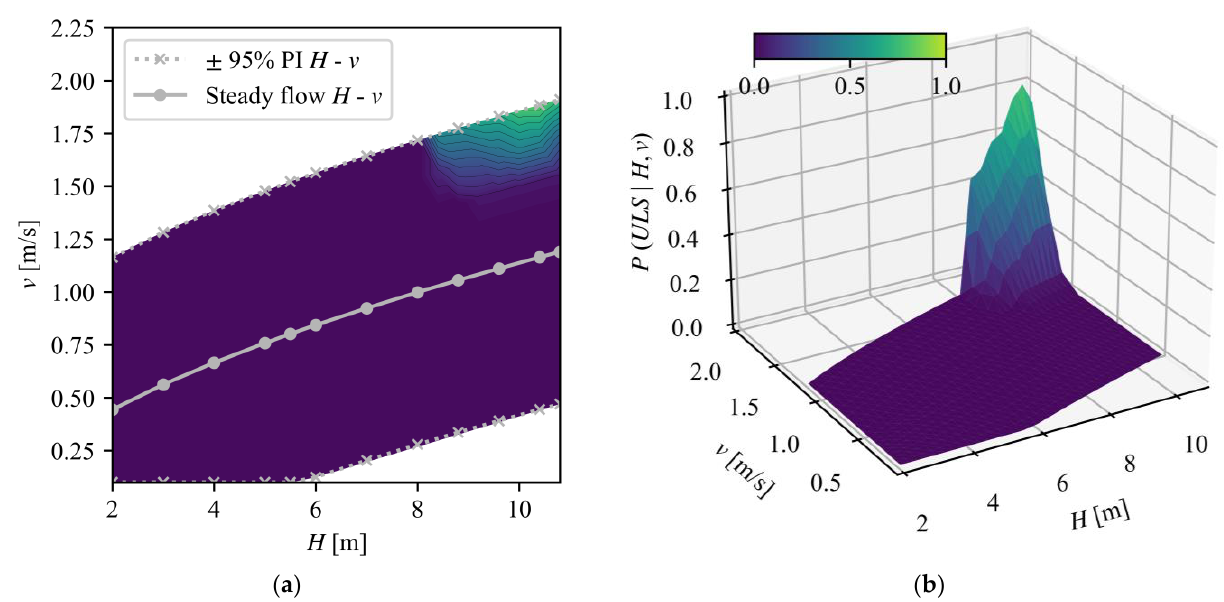
Figure 13. ( a ) Contour and ( b ) 3-D surface plot of the flood fragility surface for the ultimate limit state (ULS) for the third scenario (Panici and Almeida’s model [48]).